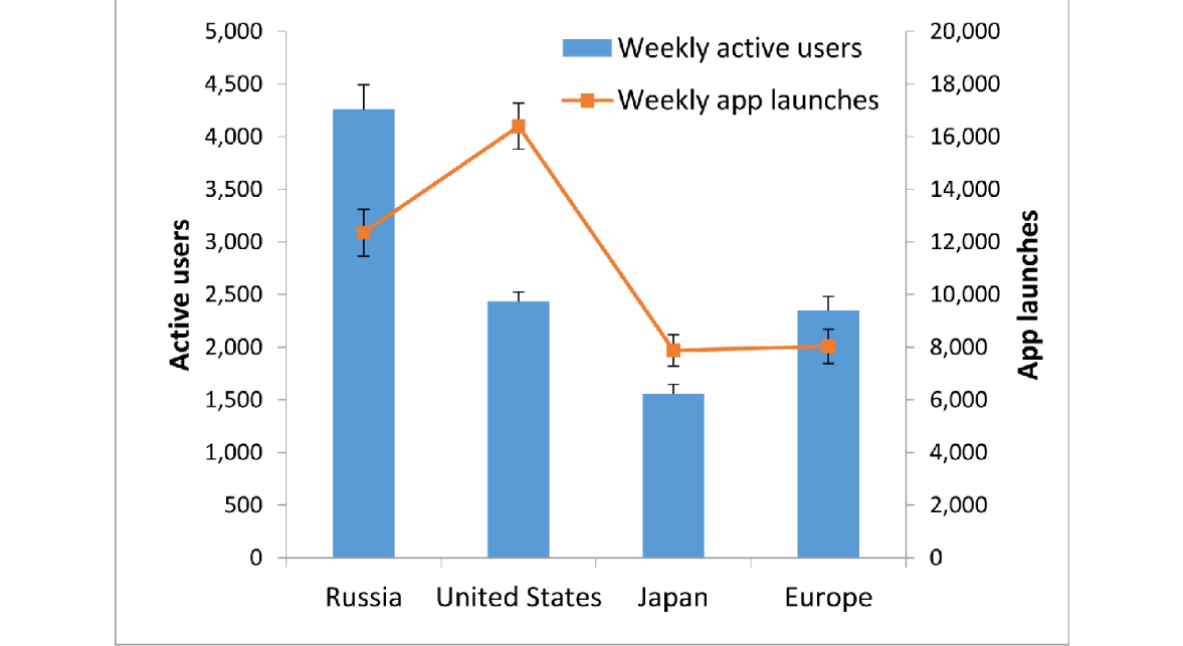
blue=easing of lockdown restrictions. It can be seen that Christmas or new year are aligned with one of the major troughs in the 4 regions. For the United States, there seemed to be an additional holiday trough around